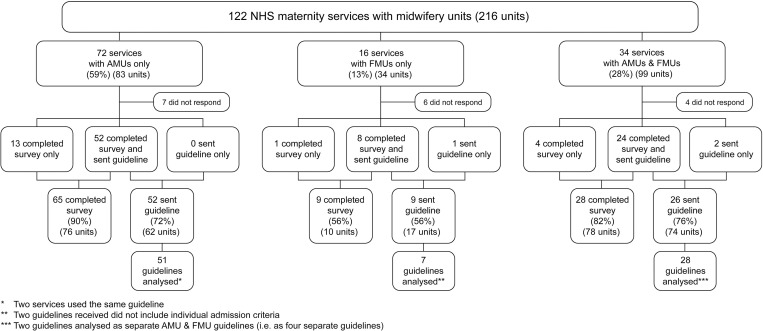
Number of maternity services completing survey and sending a guideline, and number of guidelines analysed, by configuration of care.